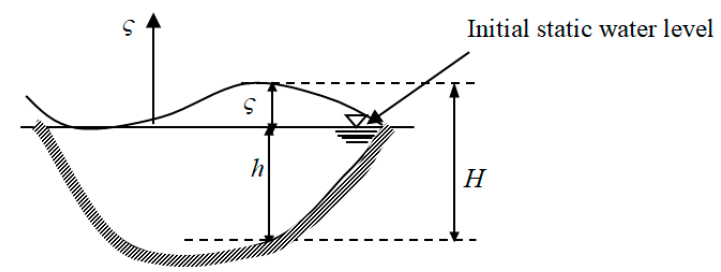
Figure 2. Illustration of the initial static level.